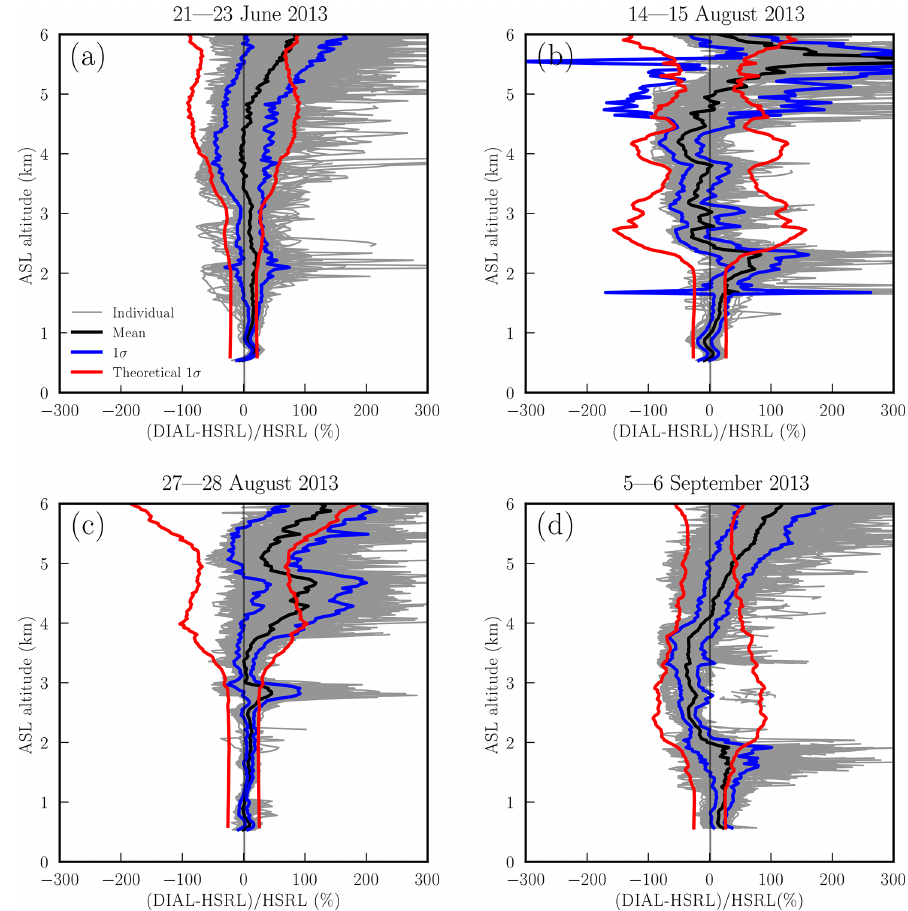
Figure 5. Relative differences between RO 3 QET- and HSRL-converted aerosol backscatter measurements, (RO 3 QET-HSRL)/HSRL, made from (a) 21–23 June, (b) 14–15 August, (c) 27–28 August, and (d) 5–6 September 2013. The gray and black lines represent the differences for the 10min individual aerosol backscatter profiles and their mean, respectively. The blue lines represent the actual 1 σ of the differences compared to the theoretical 1 σ (red lines) of the RO 3 QET lidar aerosol